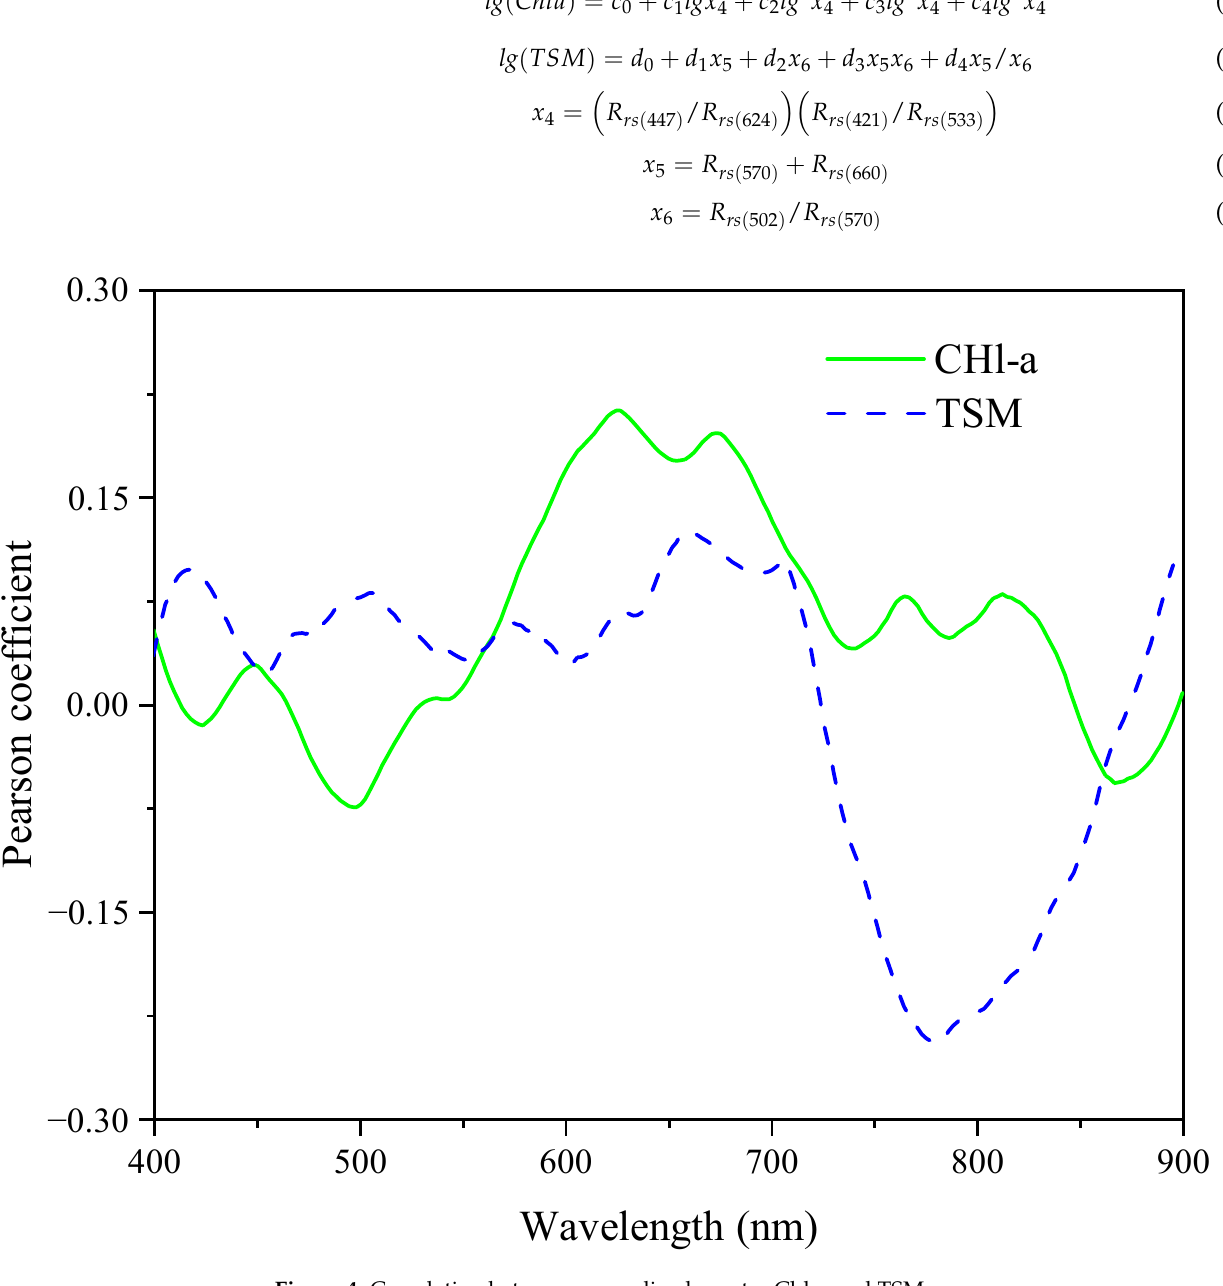
Figure 4. Correlation between normalized spectra Chl-a and TSM.